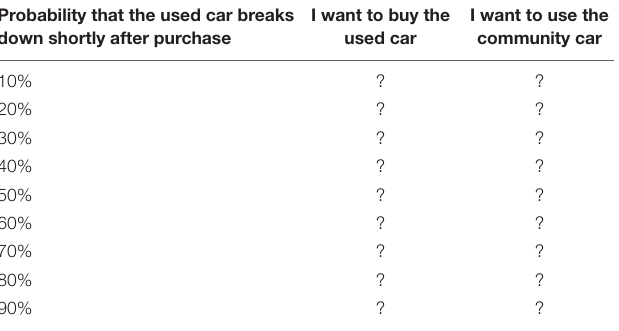
TABLE 1 | Decision between used and community